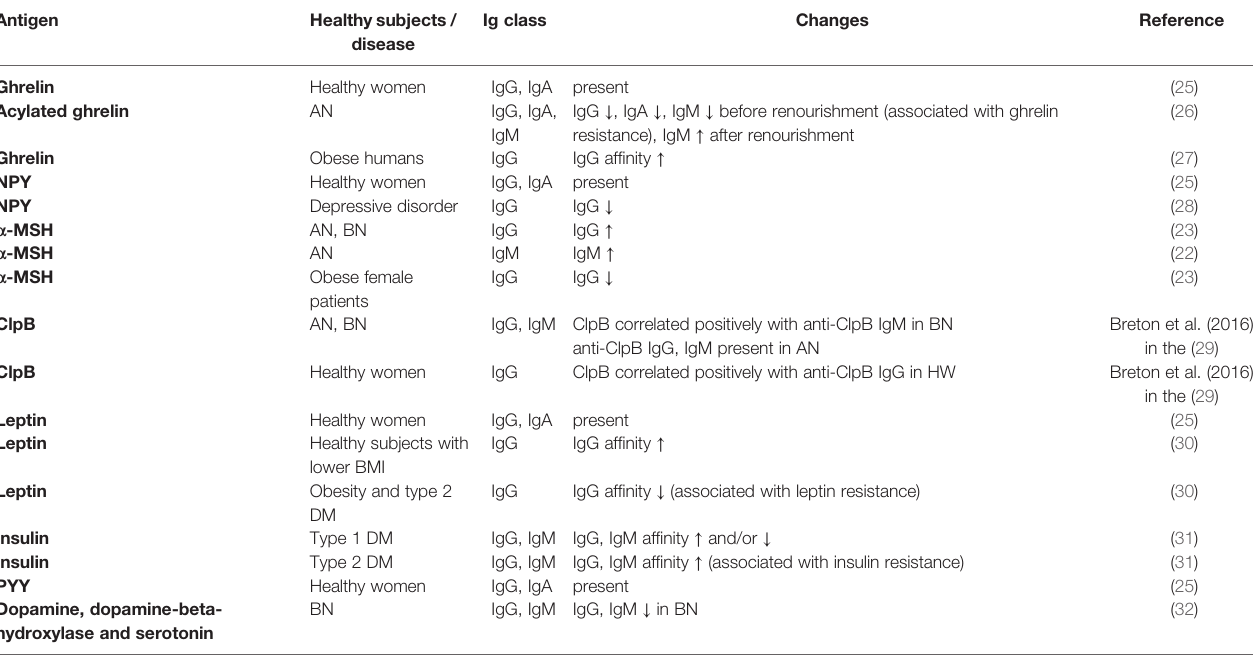
TABLE 1 | Summary of changes in autoantibodies against appetite-regulating hormones, the ClpB-mimetic protein, and neurotransmitters in AN, BN, depression, in healthy subjects, in obesity, and diabetes. Antigen Healthy subjects / Ig disease